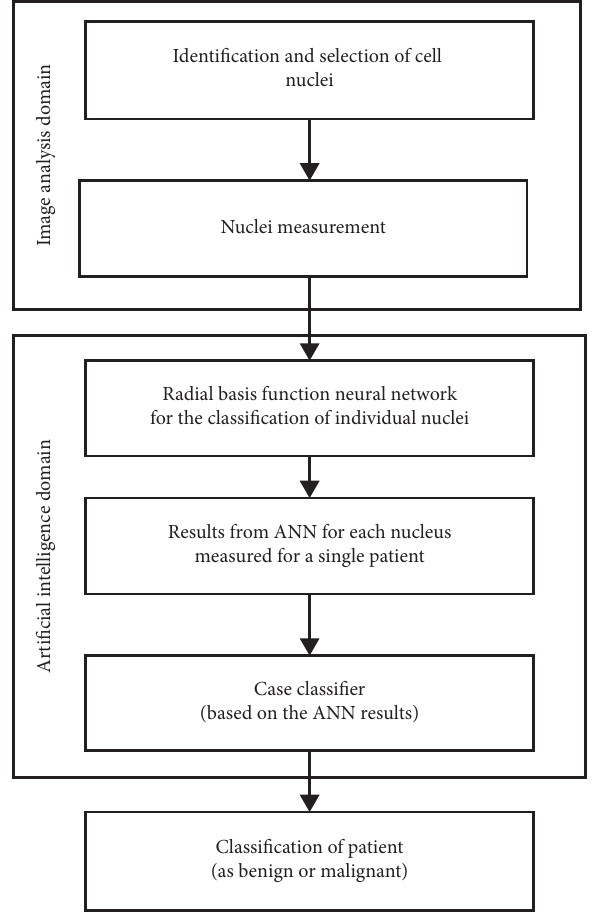
Figure 1: Flow chart of the system architecture. Table 2: Image analysis measurements categorized into geomet- rical and